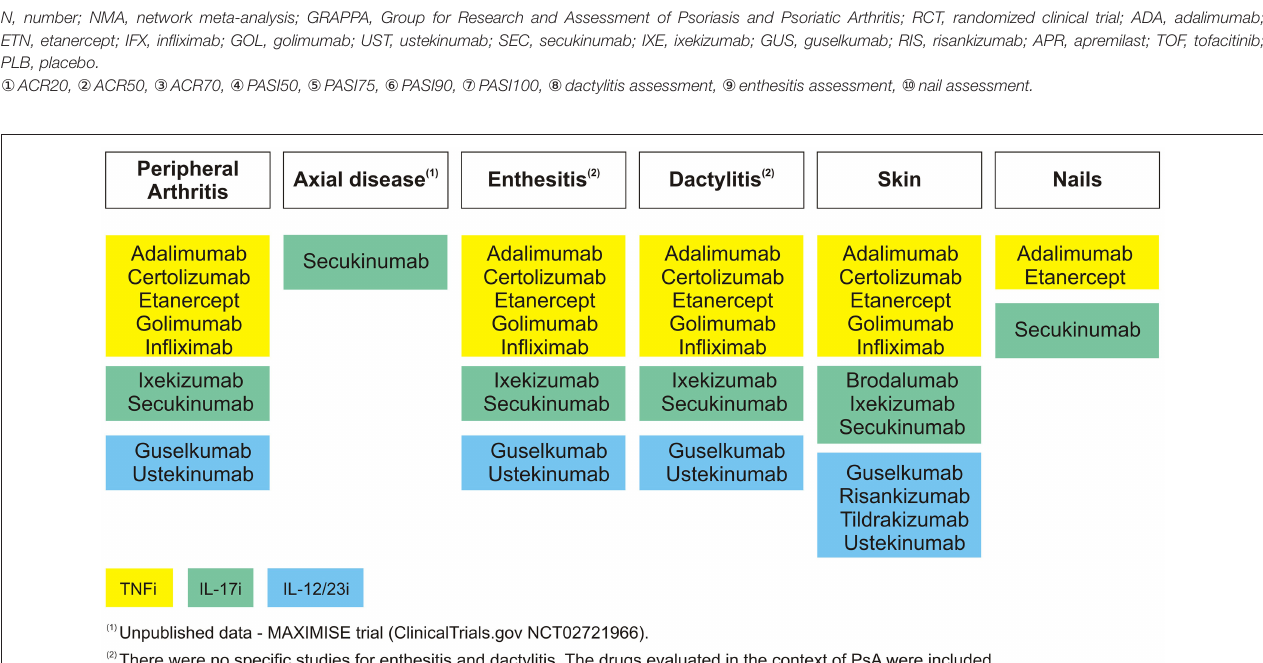
FIGURE 2 | GRAPPA domains—evaluated